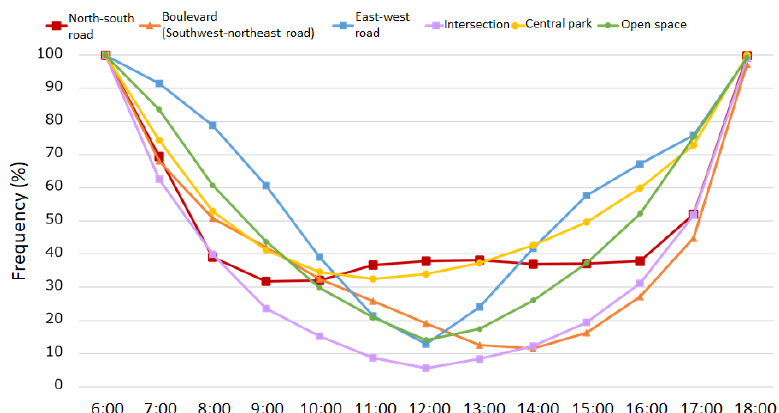
Figure 13. Diurnal variation of the modeled shaded area ratio in each study area on 5 August 2019.